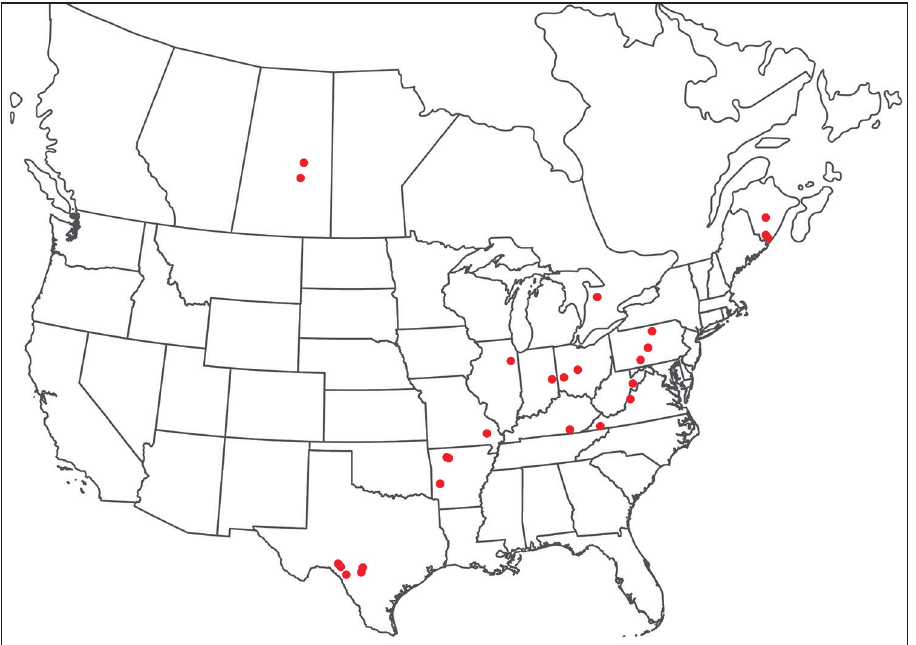
Figure 102. Torrenticola irapalpa sp. n.